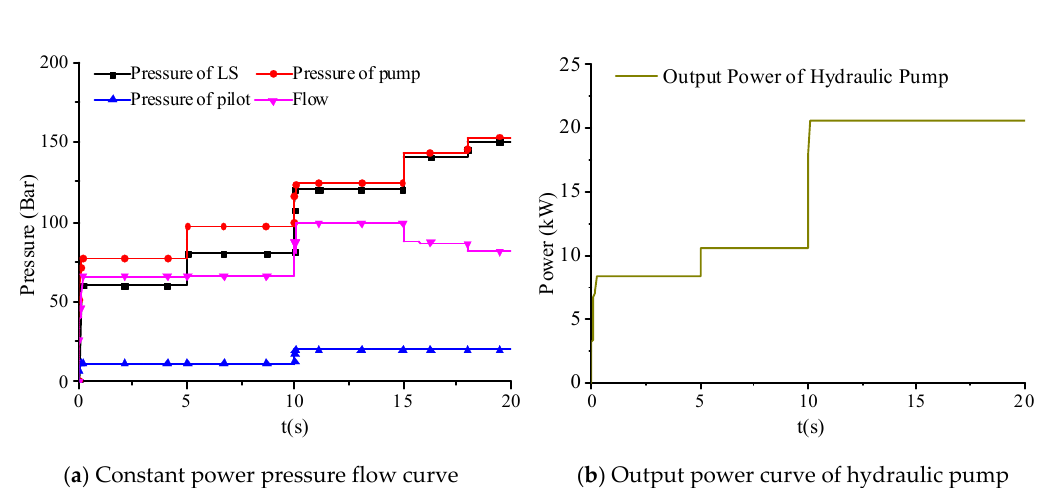
Figure 9. Simulation results.